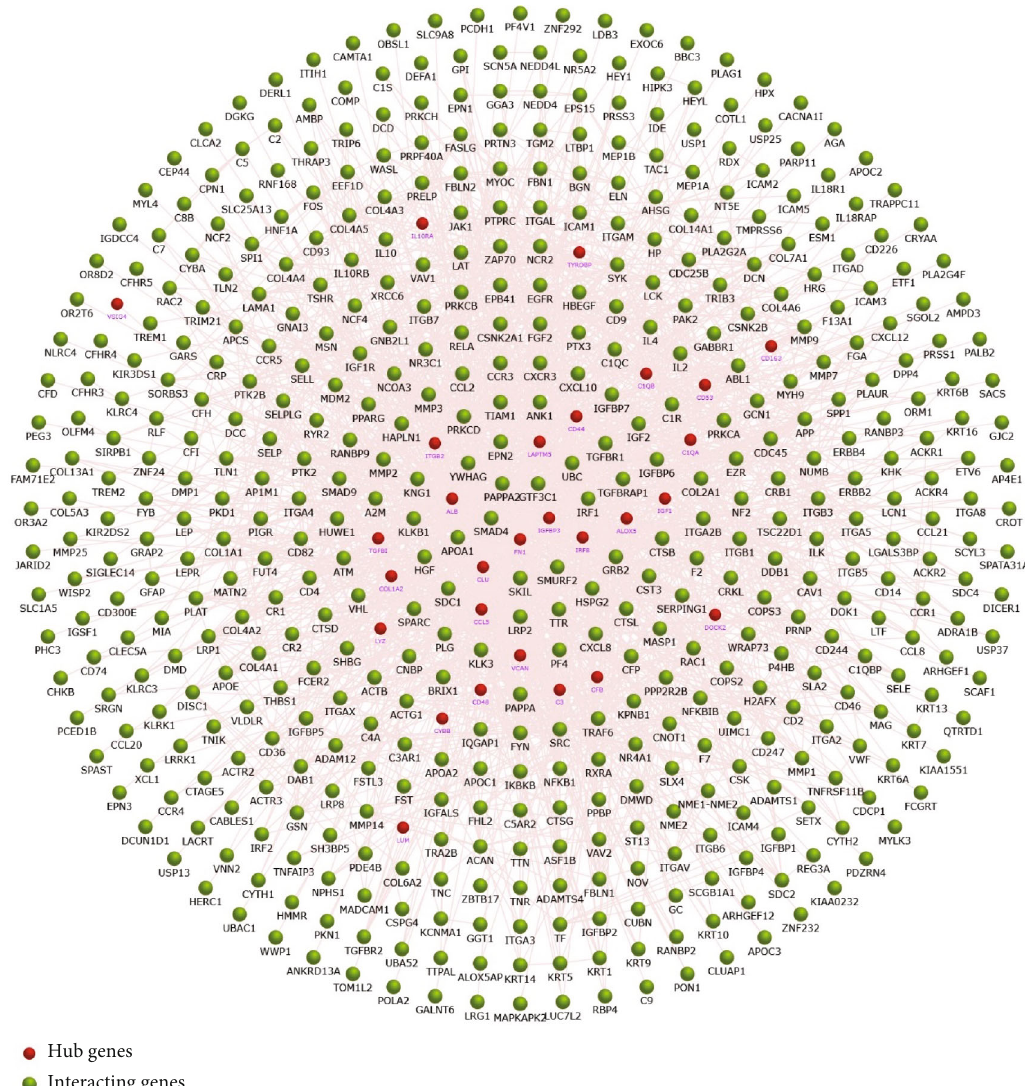
Figure 5: The coexpression network analysis of hub